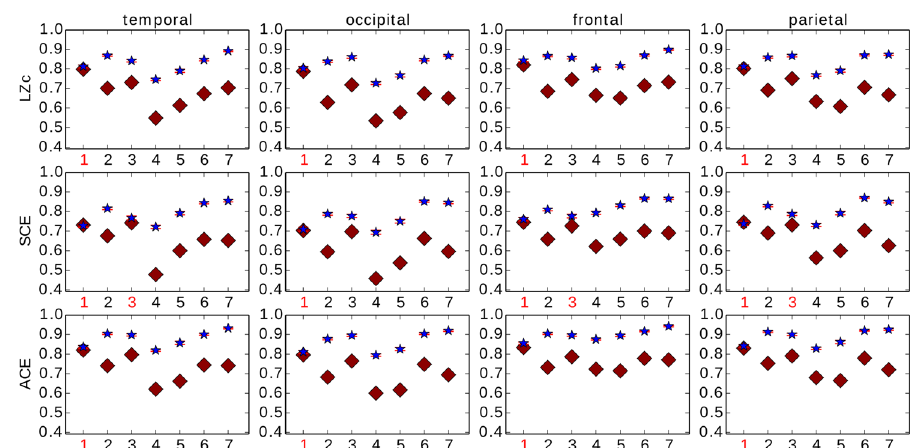
Fig 10. Analysis of 25 k-medoids chosen electrodes for each of four lobes. Blue star is WR, red diamond is LOC. The red error bars indicate standard error. LZc and ACE score for all subjects higher for WR as opposed to LOC, SCE does so for 6/7 subjects. The measures behave similarly for different brain regions. If the effect size Cohen ’ s d < 0.8 for the scores of a given subject, the subject ’ s label is printed in red.